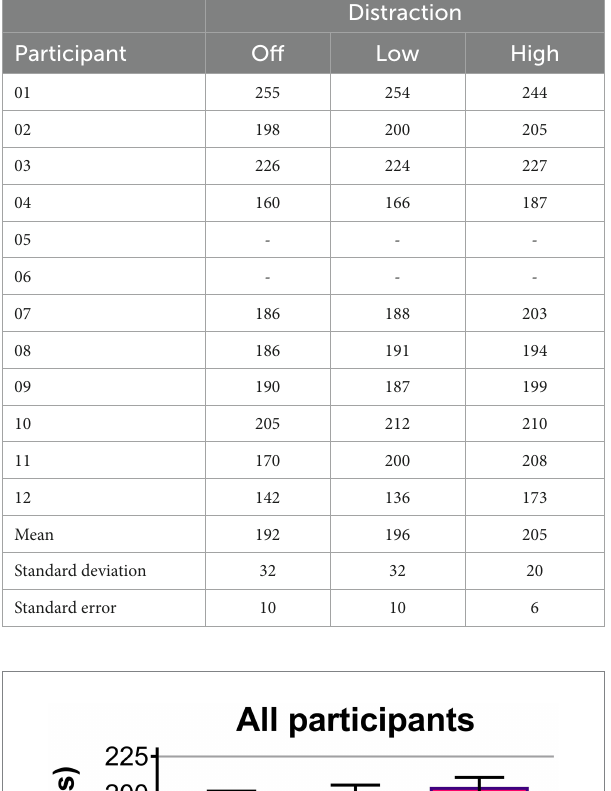
TABLE 2 Mean fixation duration (milliseconds) for each participant in each distraction condition, together with overall means, standard deviations and standard errors.